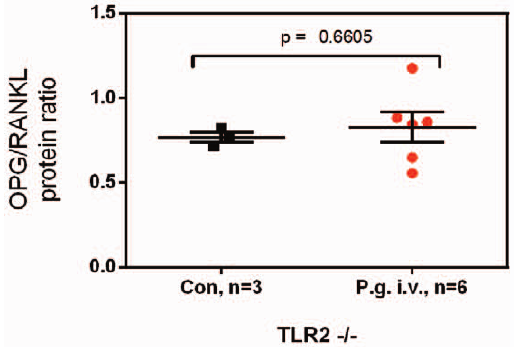
Figure 9. No differences in osteoprotegerin/RANKL ratio in the bone marrow niche of P. gingivalis infected vs. control mice deficient in TLR2. Data are given as means 6 SEM, data were analyzed using an unpaired